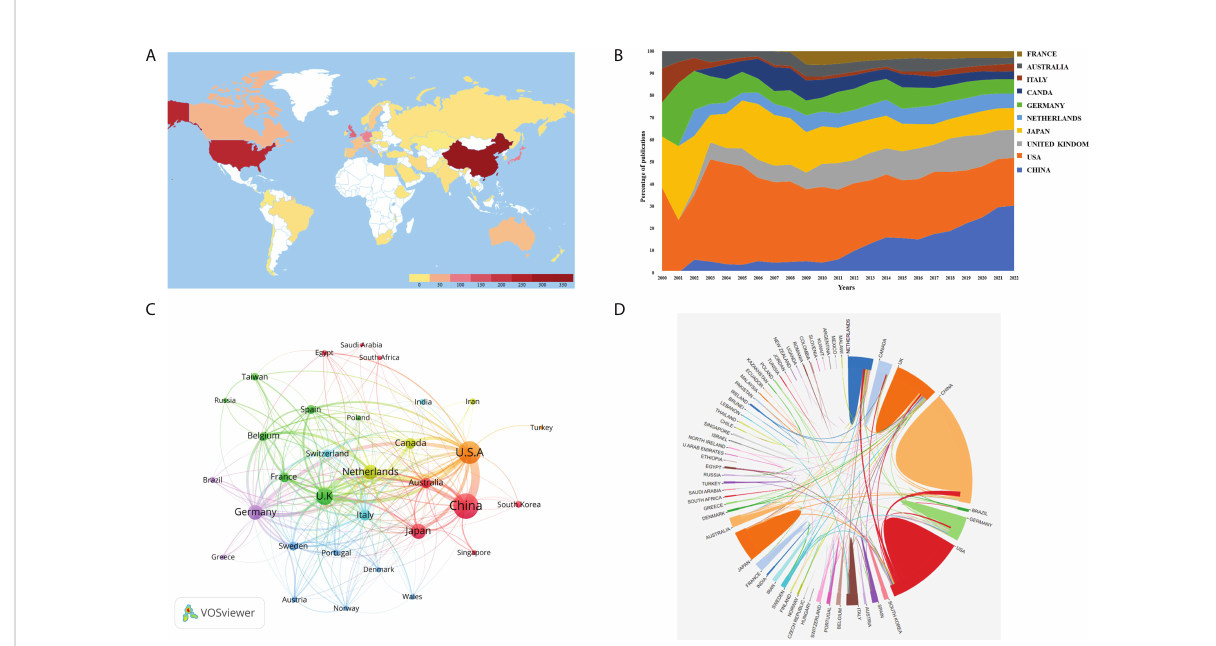
FIGURE 3 (A) World map based on the total publications of different countries/regions. (B) The changing consistence of the annual publication quantity in the top 10 countries/regions from 2000 to 2022. (C) The countries/regions' citation networkvisualization map generated by using VOSviewer. The thickness of the lines re fl ected the citation strength. (D) The international collaborations' visualization map of countries/regions. The thickness of the line between countries re fl ects the frequency of the cooperation.